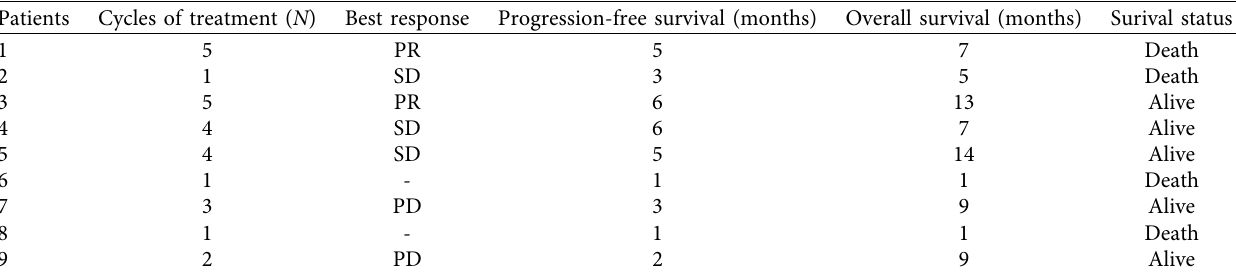
Table 2: The summary of treatment.